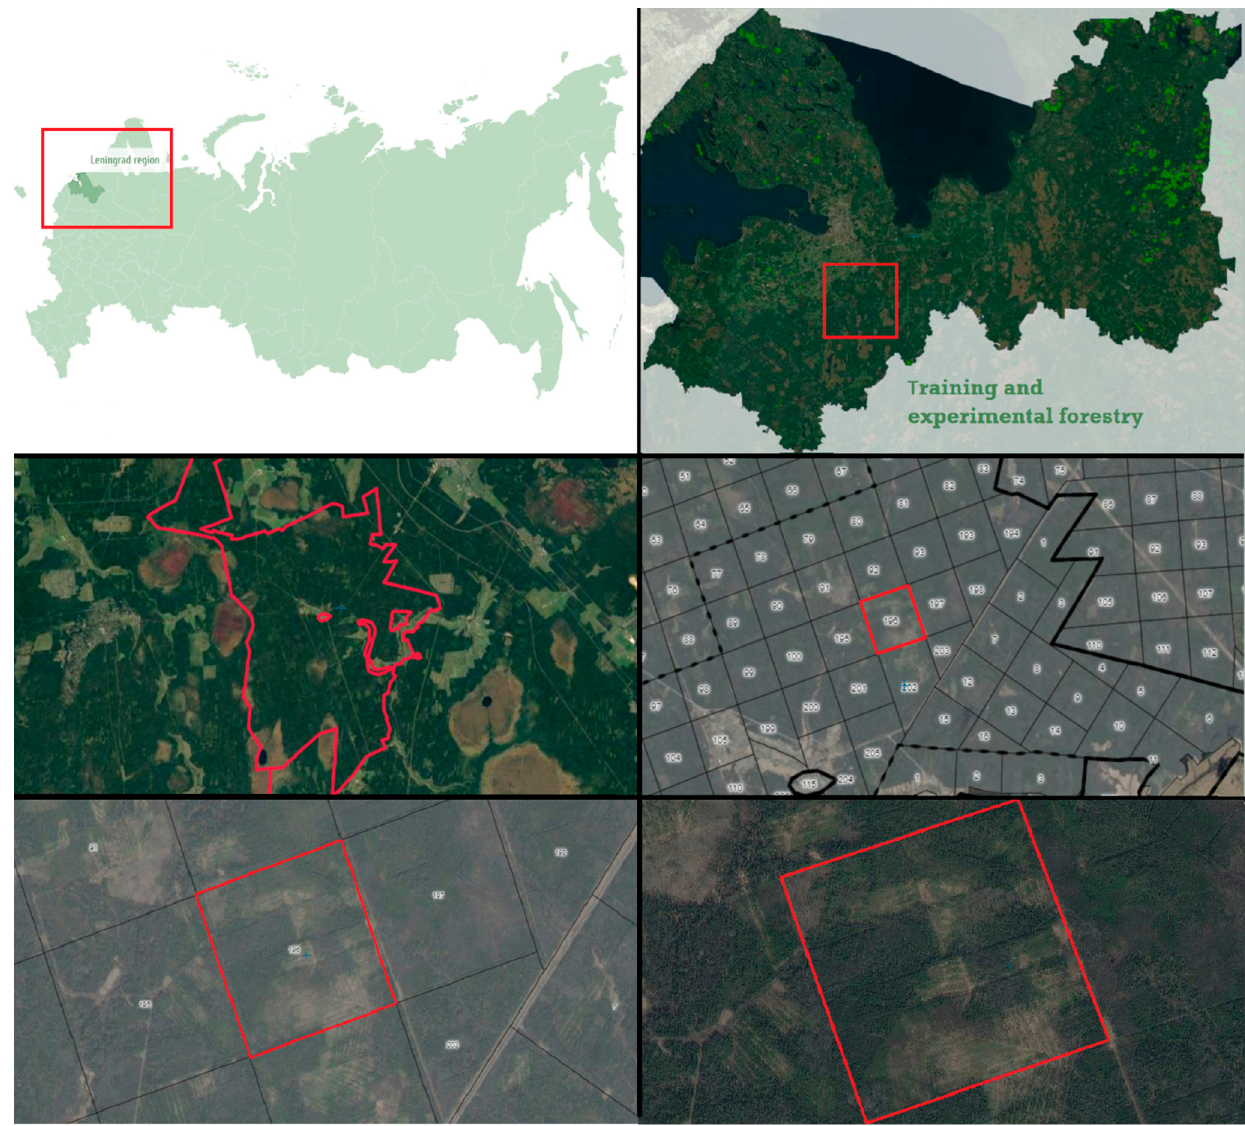
Figure 1. Selected study object.